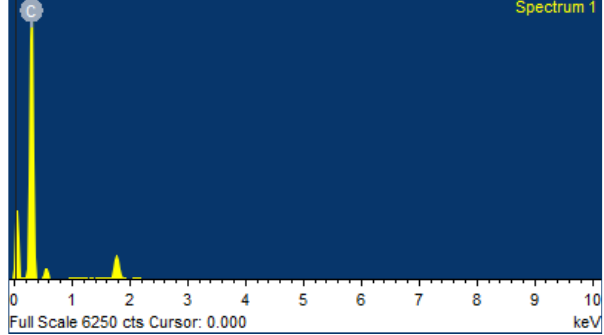
Figure 7. CNCs components measured by energy dispersive spectrometer. Figure 8 presents the thermoelectric microgenerator manufacturing flow. Taiwan